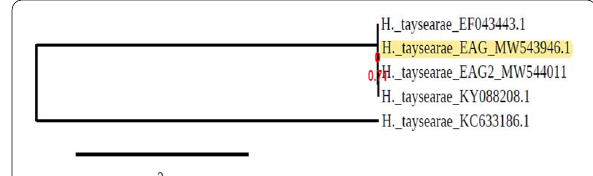
Fig. 1 Maximum likelihood ITS phylogenetic trees of Heterorhabditis species using ITS sequence. Based on nucleotide sequences of H. taysearae (alignment length approximately 500 bp using phylo_tree analysis (phylogeny.fr. program)